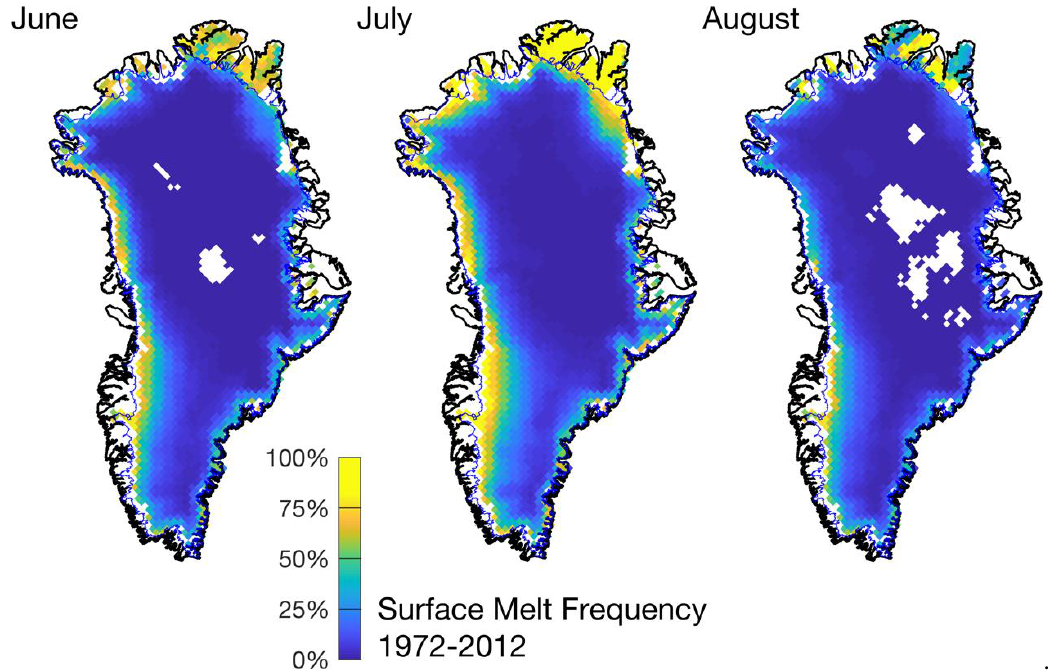
Figure 12. Surface melt presence frequency-of-occurrence during the summer melting season (June–August) for the period 1972–2012 from passive microwave brightness temperature observed by the Scanning Multichannel Microwave Radiometer (SMMR), the Special Sensor Microwave / Imager (SSM / I), and the Special Sensor Microwave Imager / Sounder (SSMIS). Areas experiencing zero melt presence frequency are colored white. Surface melt presence provides a sensitive indicator of changing climatic conditions over the Greenland Ice Sheet, including the July 2012 extreme melt event when surface melt prevailed over the entire ice sheet for the first time in the satellite era [287]. Surface melt frequency is calculated by the authors from the NASA MEaSUREs Greenland Surface Melt Daily 25 km EASE-Grid 2.0 data set [344].